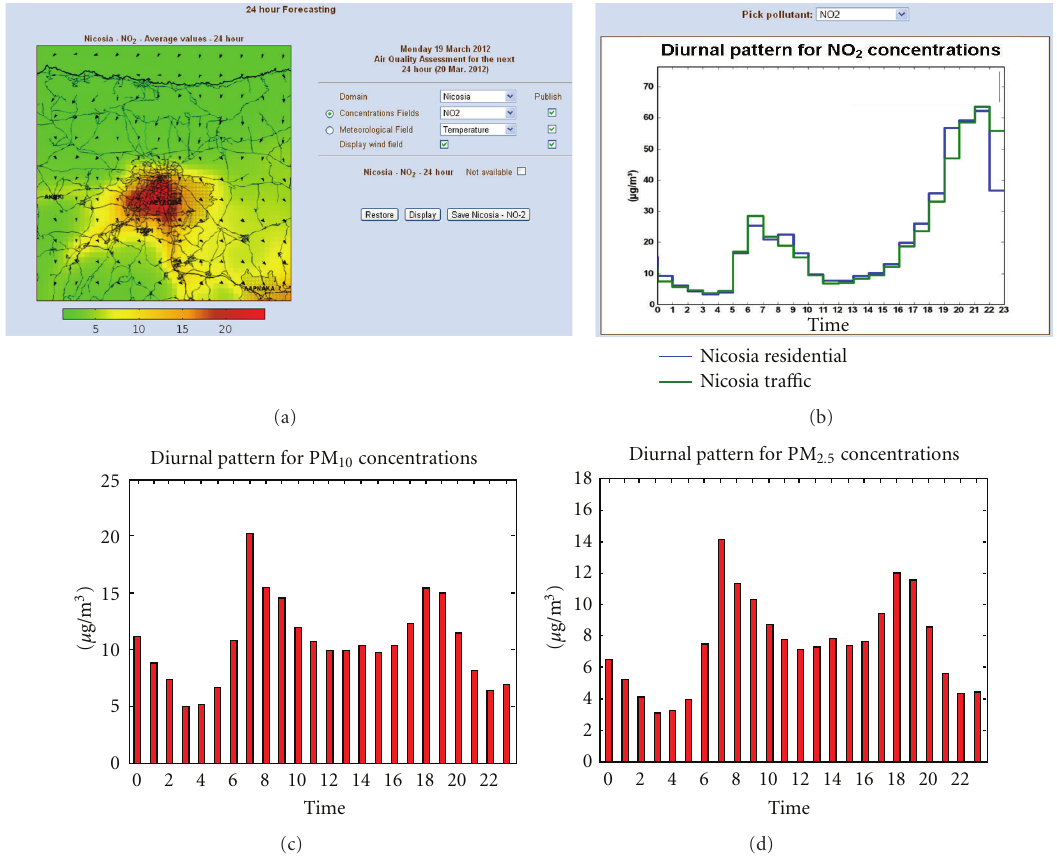
Figure 4: Snapshots of forecasting results for pollutant